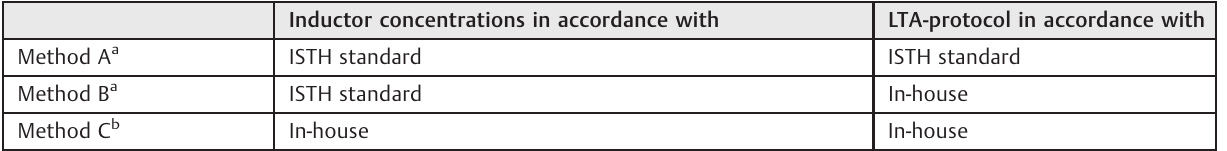
Table 1 Description of the methods for LTA Inductor concentrations in accordance with LTA-protocol in accordance with